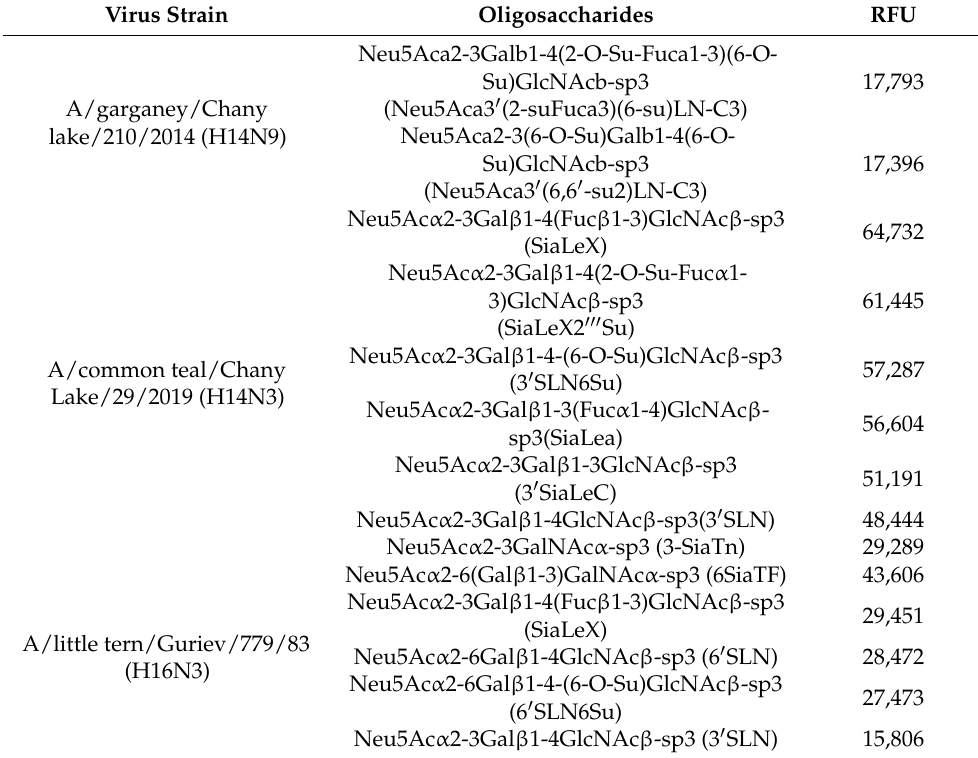
Table 4. Receptor binding glycoprofile of avian influenza viruses isolated from ducks and gulls.